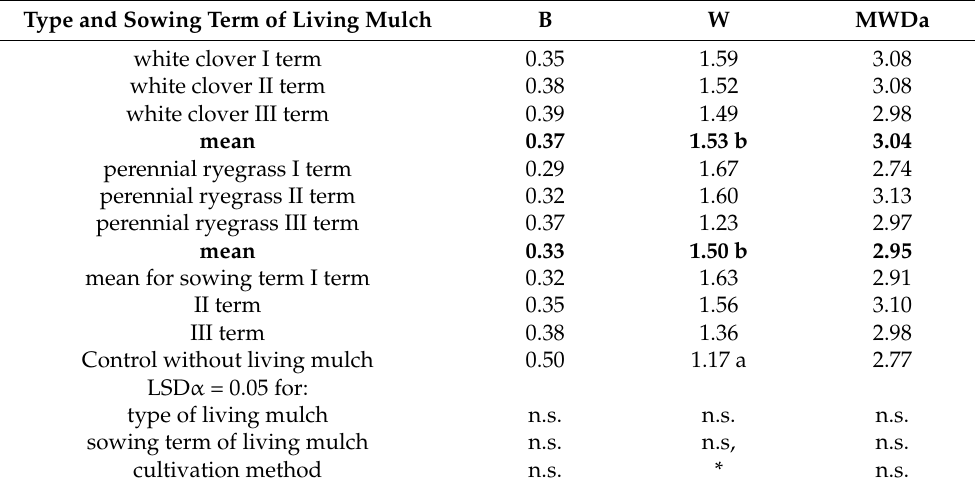
Table 2. Index of cloddiness of the soil, index of soil structure and mean weighted diameter of aggregates (dry) depending on the type and sowing term of living mulch, mean for 2010–2012. Type and Sowing Term of Living